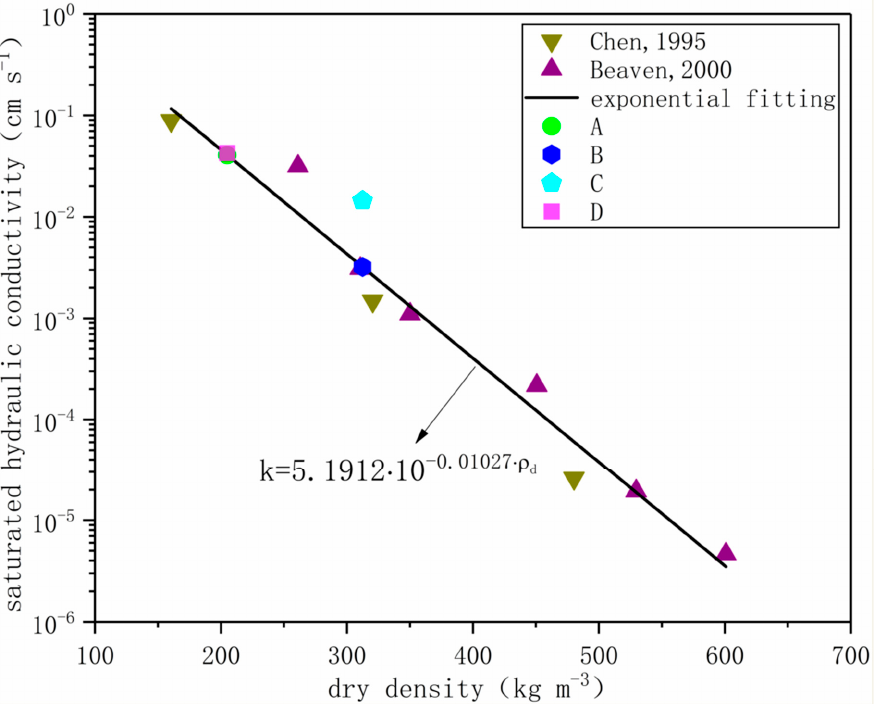
Figure 3. Relationship between saturated permeability coefficient and dry density of